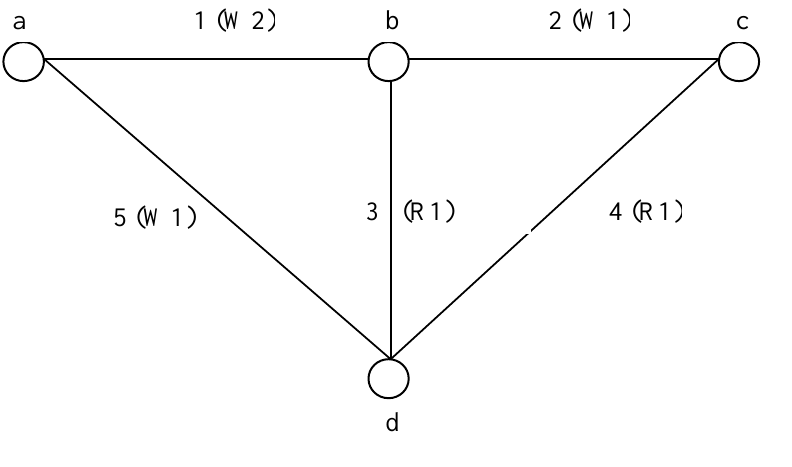
Figure 1. Multimodal